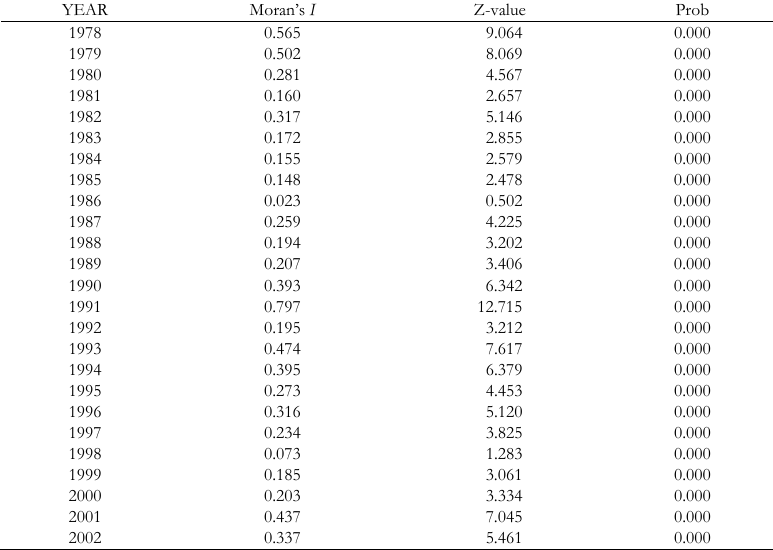
Moran's I computed for the period 1978-2002 on the annual growth rate of per-capita income YEAR Moran’s I